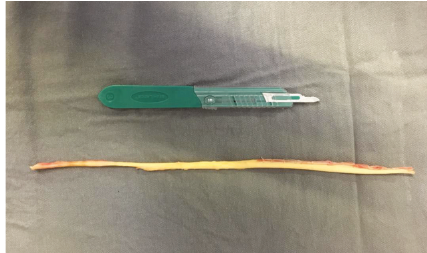
Figure 2: Patient II: the STA was debrided with the removal of its muscle belly, preserving the total length of the tendon.